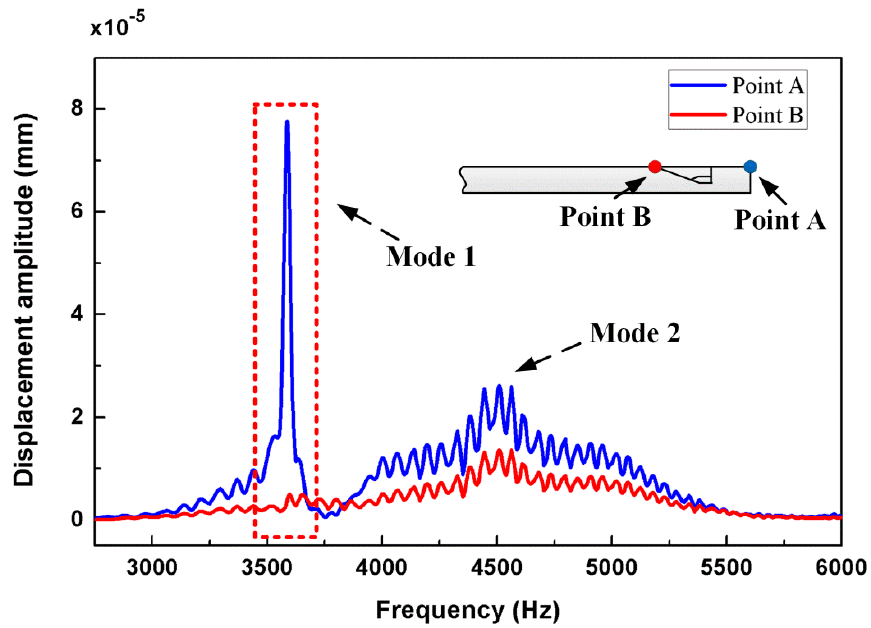
Figure 11. The transverse amplitude of the tip points at point A and B.